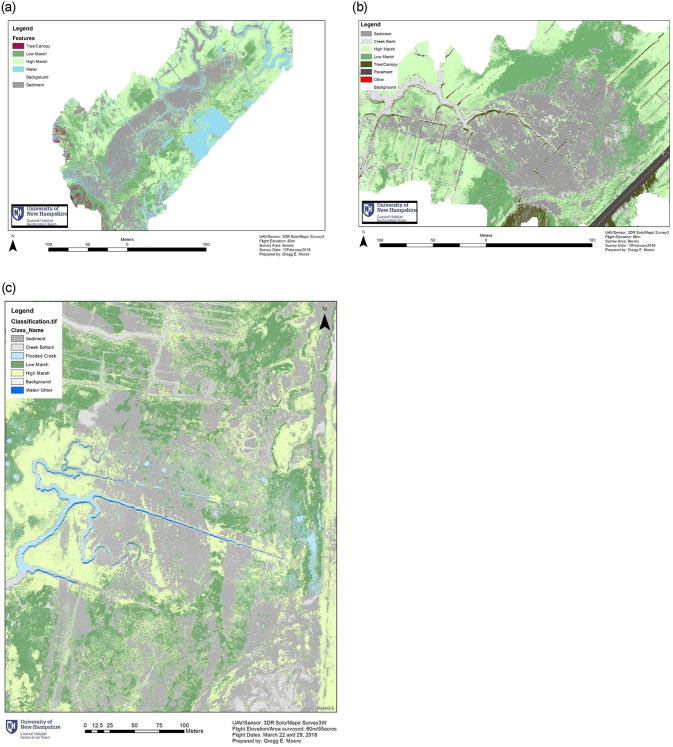
Sediment area supervised classification map.(a) Essex Bay (b) Jefferies Neck (c) Plum Island.